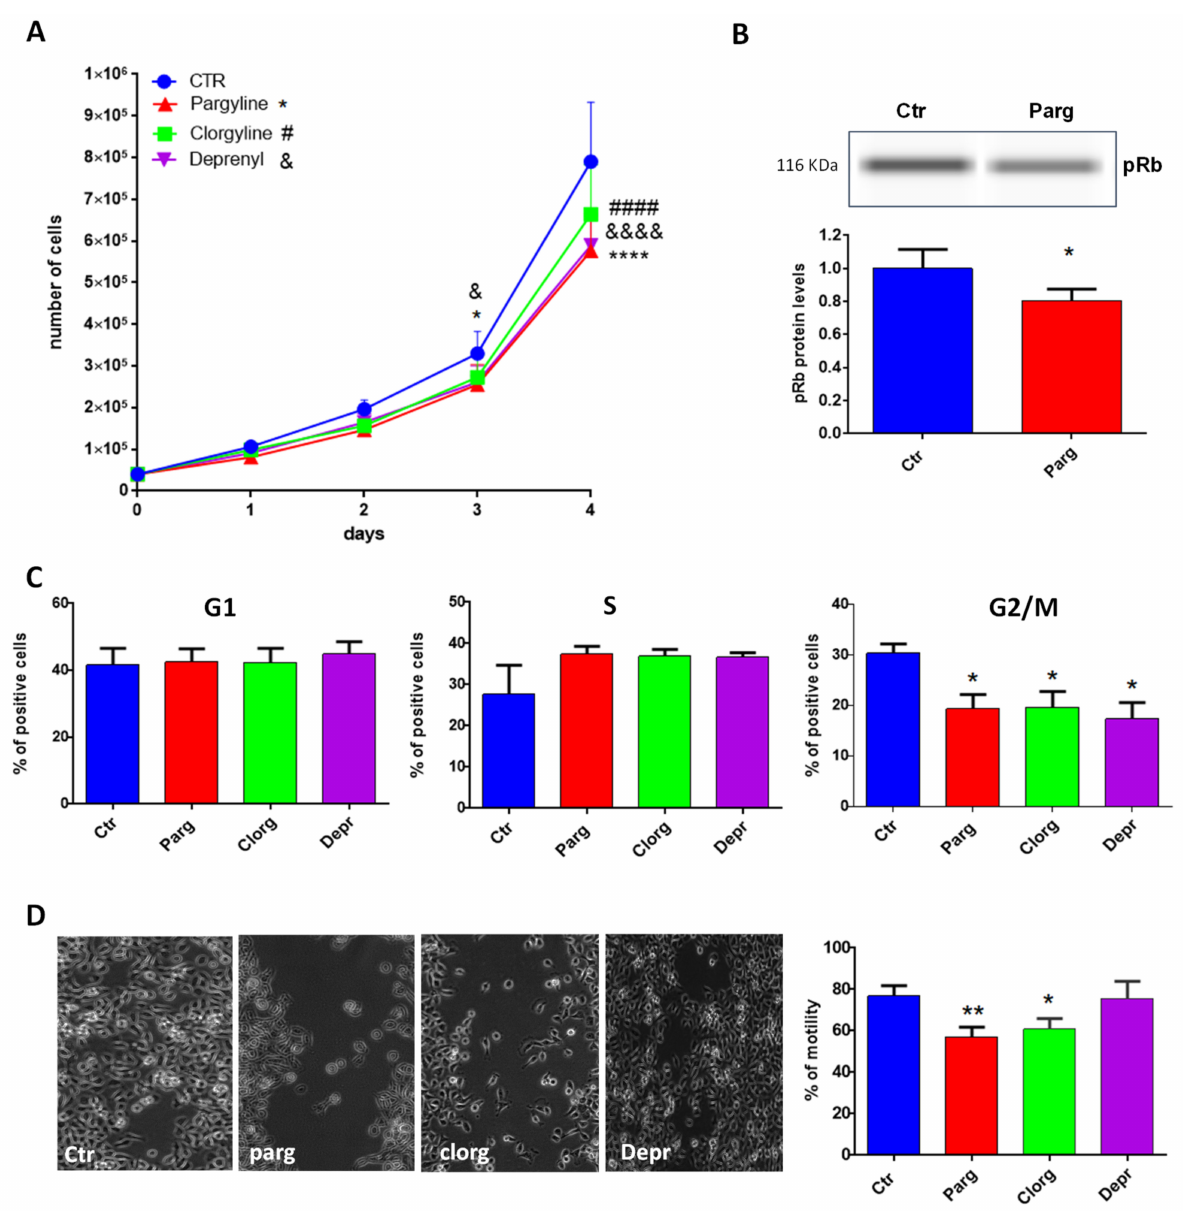
Figure 2. MAO effects on proliferation and motility. ( A ) Proliferation curve of AY27 cells cultured in standard media supplemented or not with different inhibitors (pargyline 10 − 5 M, clorgyline 10 − 6